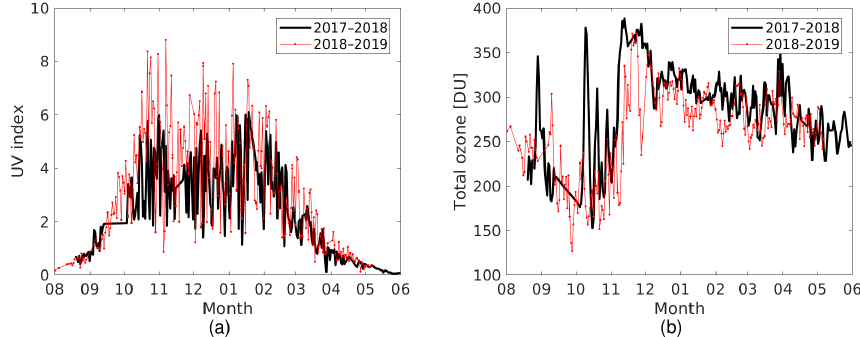
Figure 6. UV index (a) and total ozone (b) at noon calculated from the Marambio GUV radiometer measurements for the months August– May in 2017–2018 and 2018–2019. Table 4. Monthly means of GUV radiometer products measured at Marambio during the period March 2017–April 2019. Months with more than 15 measurement days are included. A single standard deviation is shown in the parentheses. DD is the daily dose, DMDR is the daily maximum dose rate, DM is the daily maximum and VIS is irradiance measured at